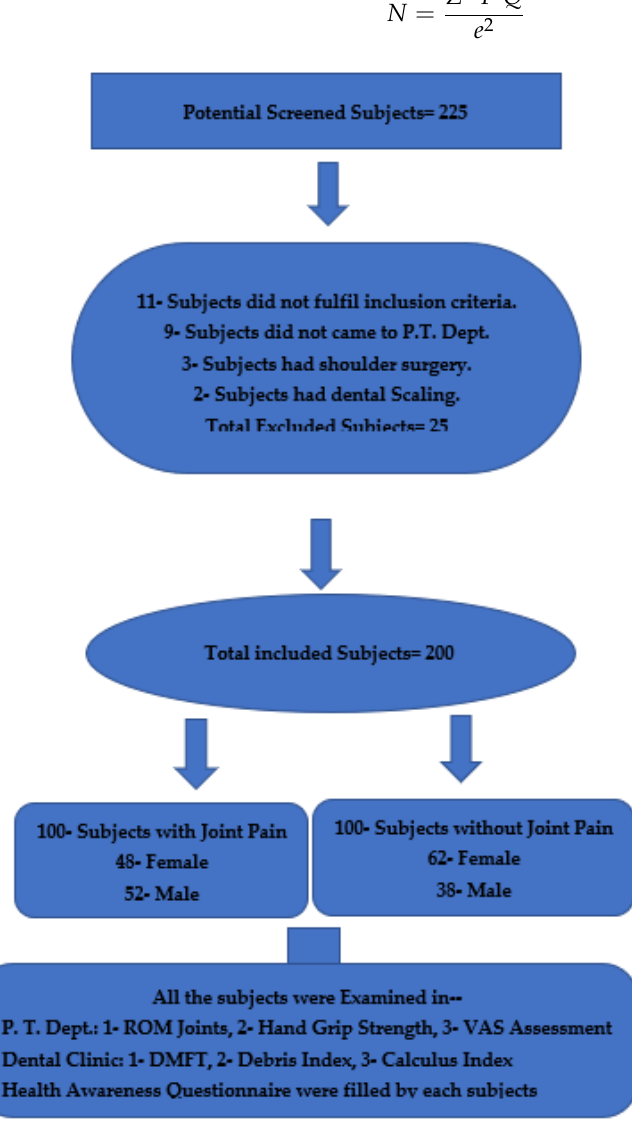
Figure 1. Participants’